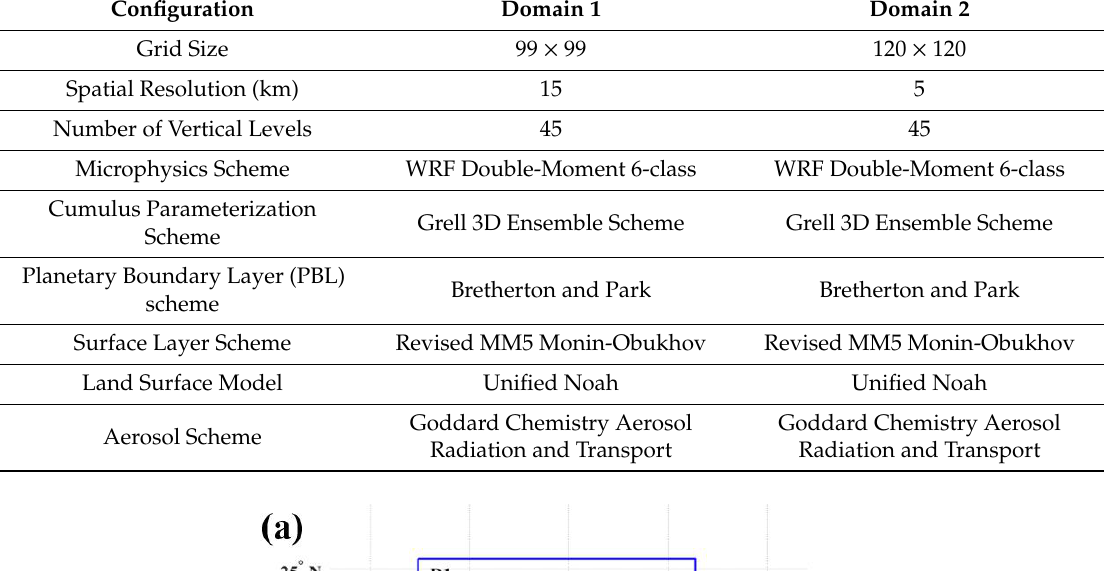
Table 2. WRF-Chem domain configurations and physics options employed in this study.